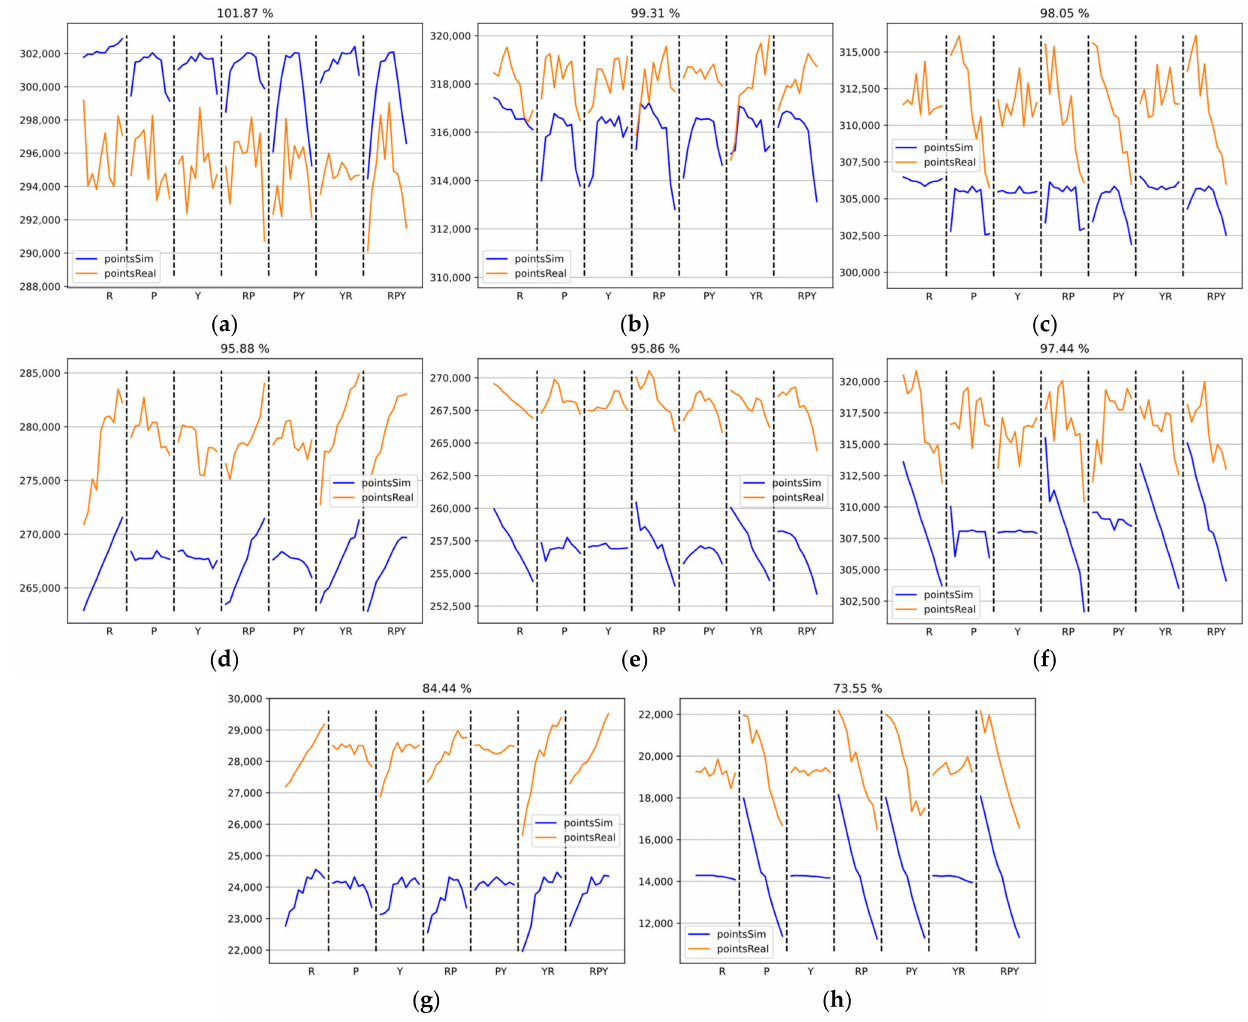
Figure 9. Comparison of the number of points in the point cloud obtained by each sensor during the whole measurement for Objects A, B, and C in the simulation (blue line) and on the real system (orange line). The Y-axis represents the number of points in the point cloud. The X-axis represents the measurement, where the individual rotation sequences are separated by a black dashed line (e.g., R is the rotation in Roll from − 2 ◦ to +2 ◦ , RP is the rotation in Roll and Pitch, etc.). The percentages represent the match of the simulation with the actual measurement: ( a ) Object A, sensor no. 1; ( b ) Object A, sensor no. 2; ( c ) Object A, sensor no. 3; ( d ) Object B, sensor no. 1; ( e ) Object B, sensor no. 2; ( f ) Object B, sensor no. 3; ( g ) Object C, sensor no. 2; ( h ) Object C, sensor no.